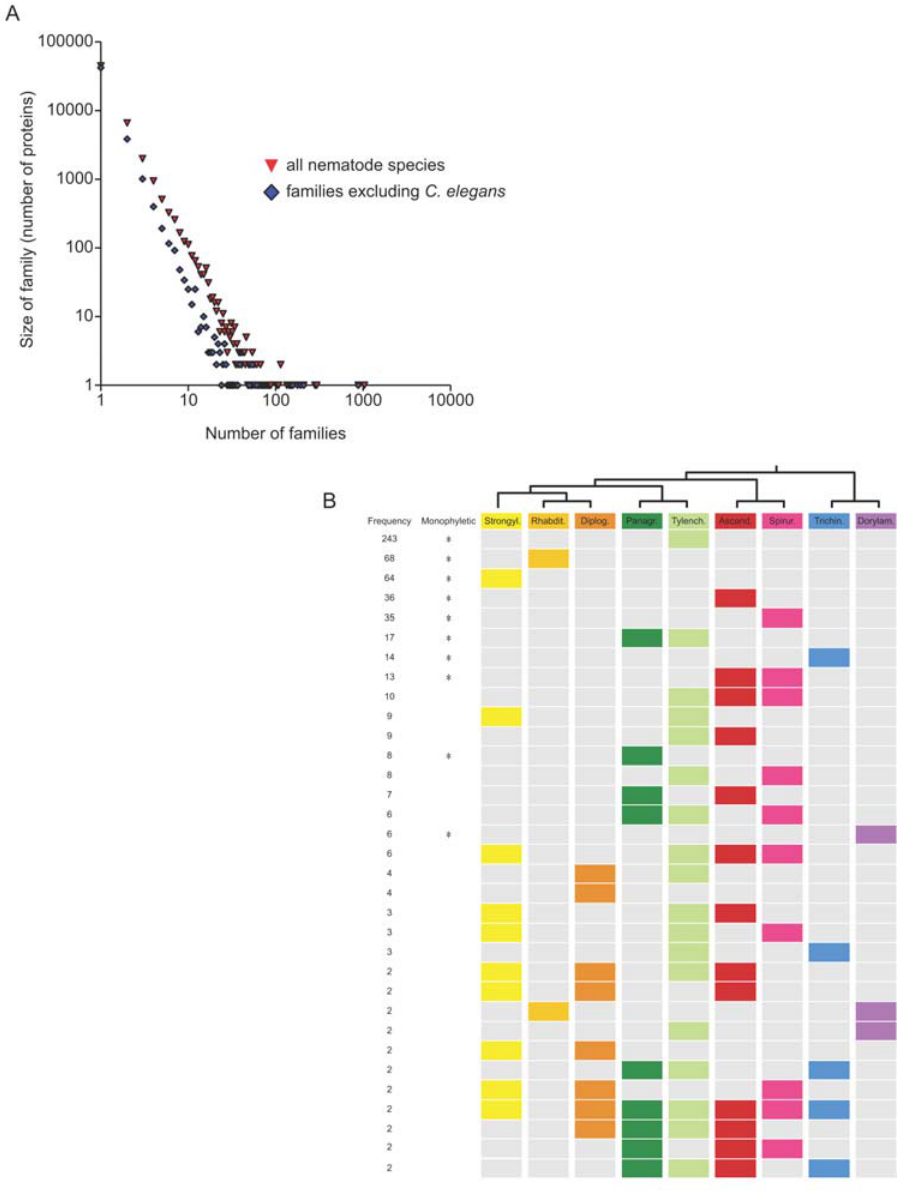
Figure 3. Nematode-restricted protein families. (A) Distribution of protein family size can be described by a power law, with a large number of small families and the number of families decreasing as their size increases. Removing C. elegans- containing families reduced the total number of families, but the power law distribution persisted. (B) Many protein families had restricted taxonomic distribution within Nematoda. For all protein families with at least five non- C. elegans members, the systematic affinities of the contributing species were compared. Proteins families were identified that were restricted to each of the taxonomic families represented in the analysis, and to higher-level taxonomic groups (e.g. the Spirurina which includes Ascaridomorpha and Spiruromorpha). For example, 243 protein families were restricted to the Tylenchomorpha One species from a taxonomic family needed to be represented in the protein family for inclusion in the figure.